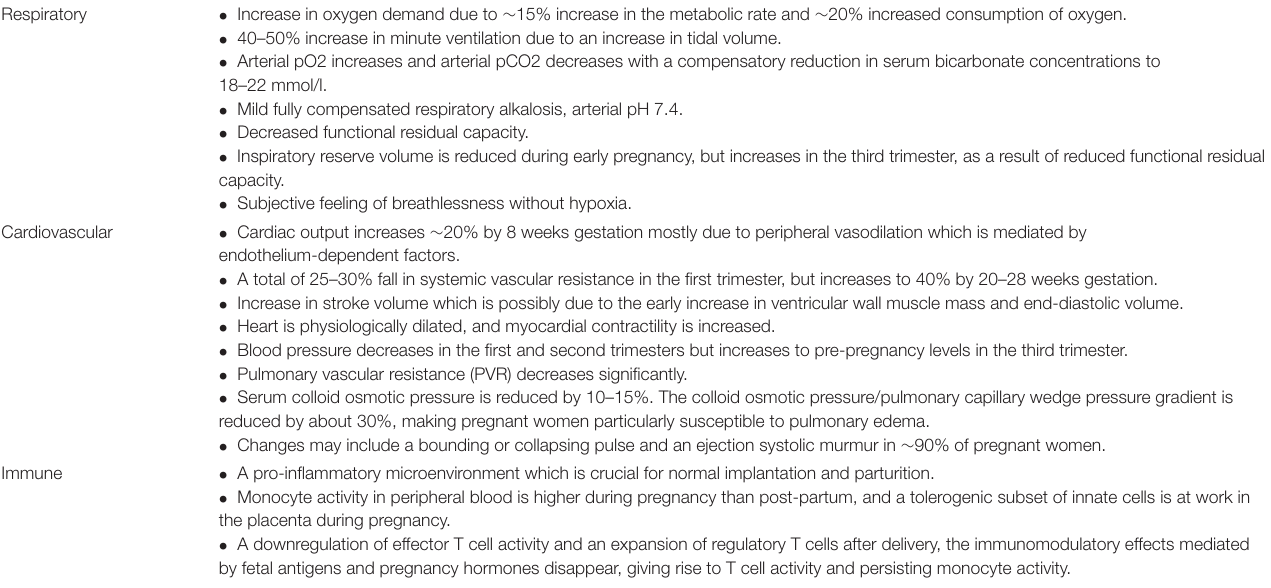
TABLE 3 | Physiological changes of pregnancy that make pregnant women more susceptible to infection 2 (Soma-Pillay et al., 2016; Förger and Villiger, 2020).